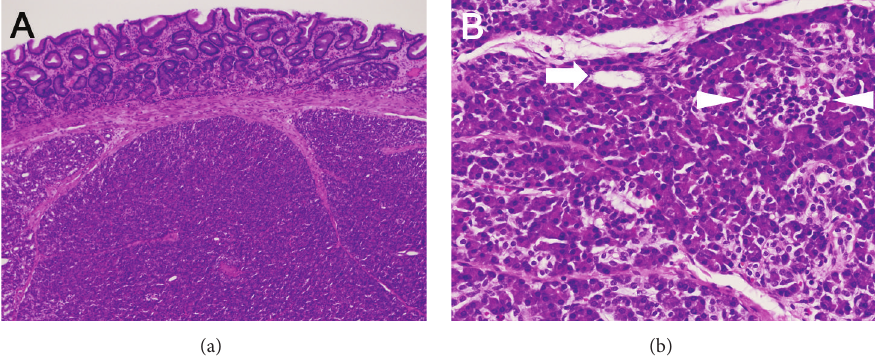
Figure 3: Pathological images. The tumor was located in the submucosal layer (a, hematoxylin and eosin [H&E] staining, × 4.2). Pancreatic tissues composed of acini, ducts (arrow), and islets of Langerhans (arrowheads) were seen in the tumor (b, H&E staining, × 20).